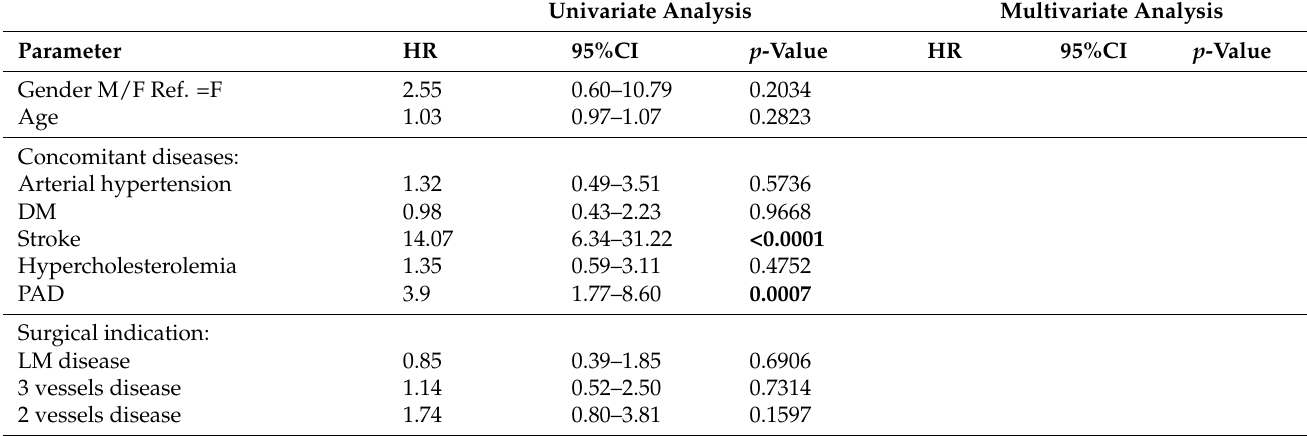
Table 3. Univariable and multivariable Cox’s proportional hazard regression